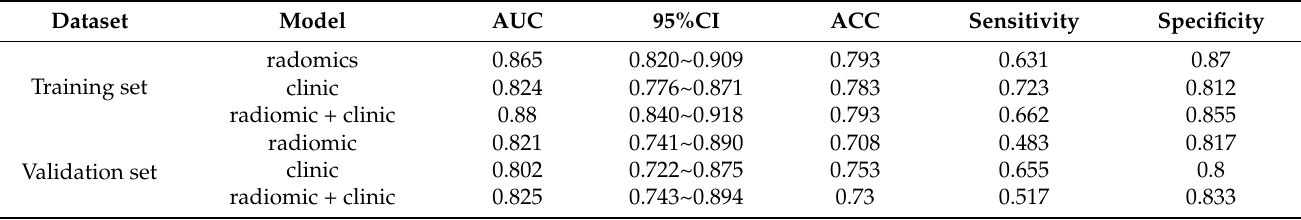
Table 2. Model results for prediction of CDKN2A/B homozygous